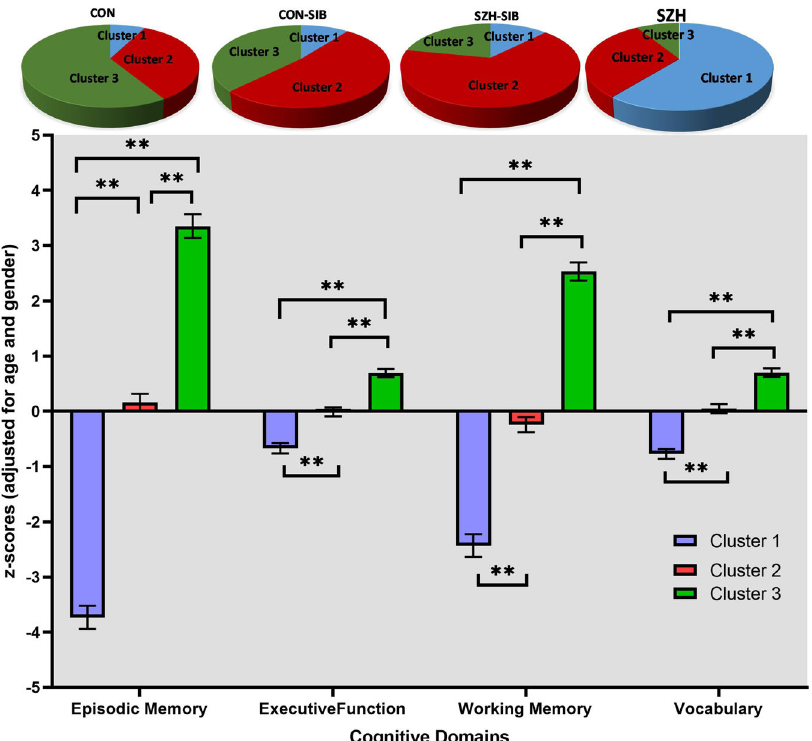
Fig. 1 Group Differences in Cognitive Scores among Clusters. Controls (CON), their siblings (CON-SIB), schizophrenia patients (SZH), and their unaffected siblings (SZH-SIB). ** Post hoc p < 0.01, * Post hoc p <